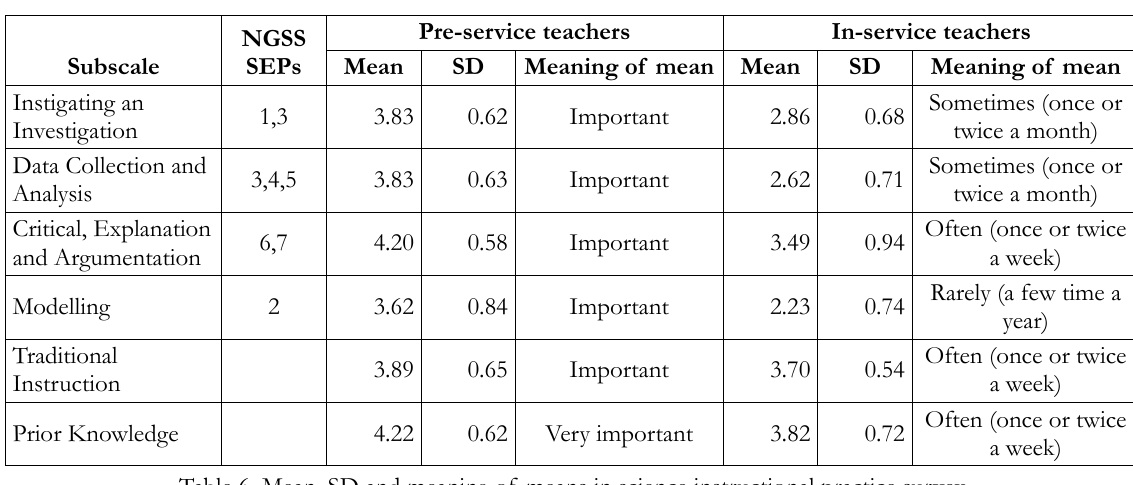
Table 6. Mean, SD and meaning of means in science instructional practice survey